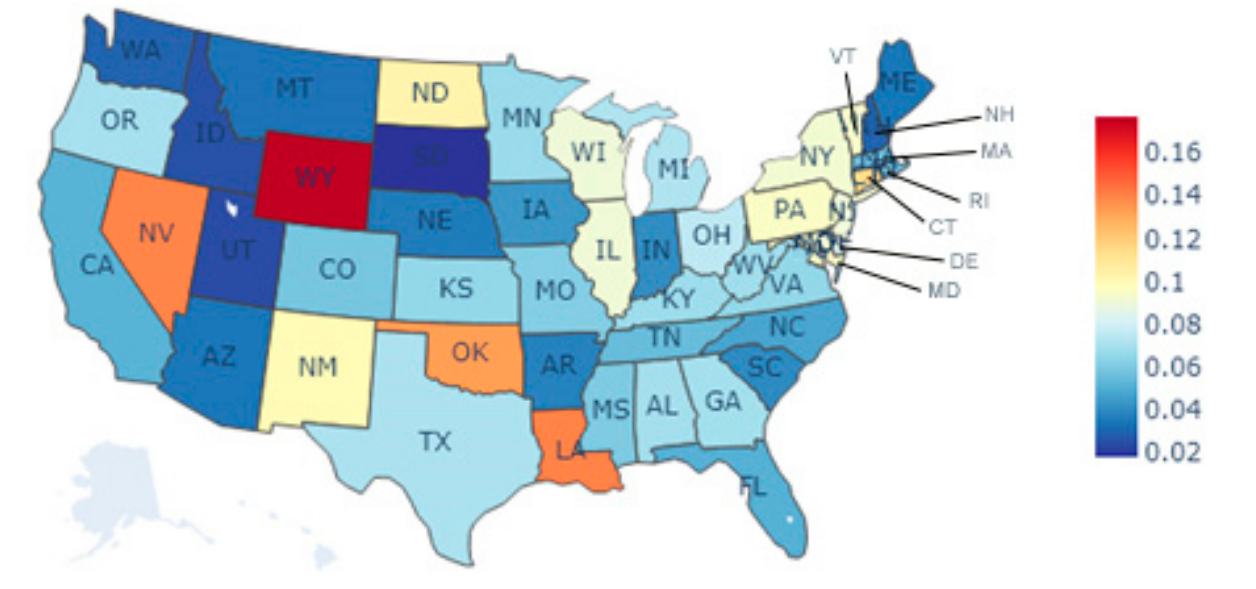
Figure 5. Total loss of GDP until recovery to pre-pandemic trends as a share of the GDP level in 2019.